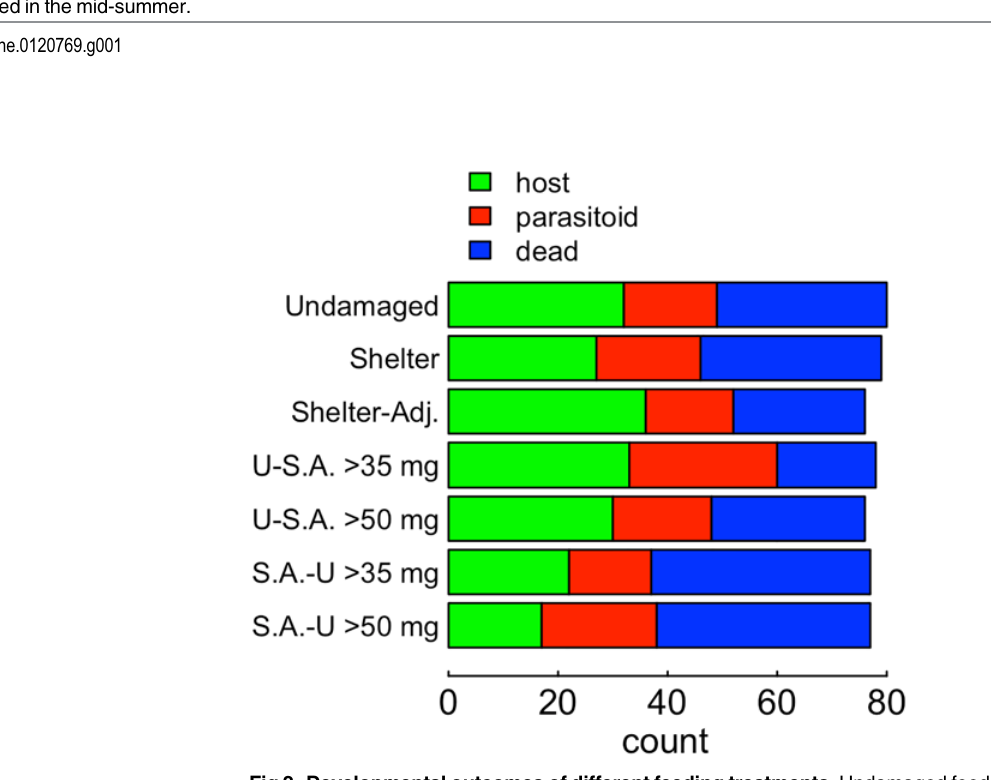
Fig 2. Developmental outcomes of different feeding treatments. Undamaged food was made up of distal pinnae (analogous in position to those used in shelter construction) from ferns with no evidence of herbivory. Shelter food was made up of pinnae from within shelters, and shelter-adjacent, pinnae adjacent to shelters. Switched treatments were switched between undamaged (U) and shelter-adjacent (S.A.) food in the direction and on the first day they exceeded either 35 or 50 mg, as